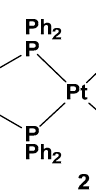
Figure 3. Dichloride cis -Pt(II) complex (complex 2 ).